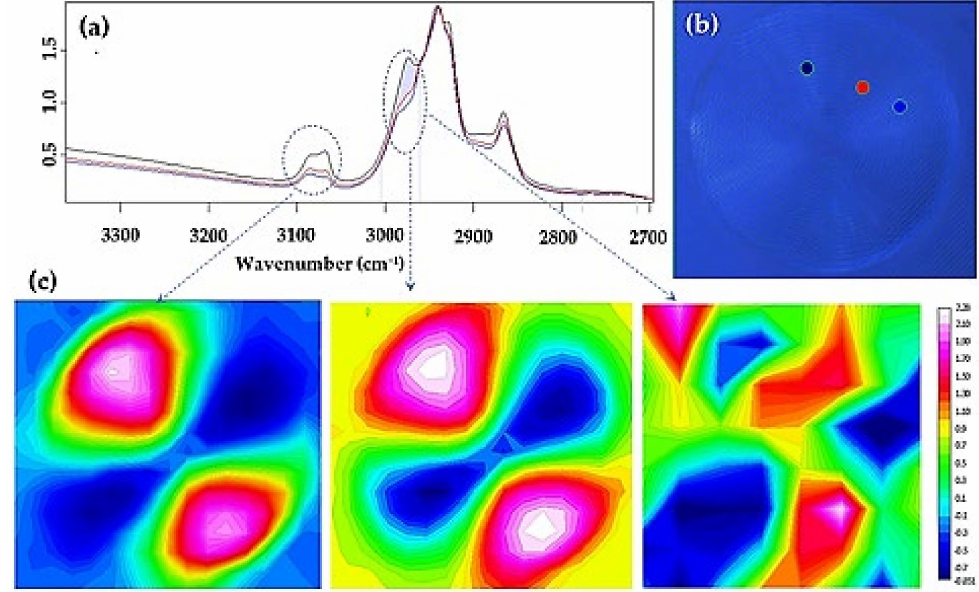
Figure 6. ( a ) FTIR spectra showing the C–H stretching region for PLC and taken from three represen- tative microdomains of the spherulite. ( b ) Micrograph showing a representative banded spherulite and the specific microdomains where FTIR spectra were recorded. Colors are in agreement with those of the FTIR spectra. ( c ) Chemical images obtained from the FTIR bands pointed out by the circle and the ellipsoid. Left and middle images correspond to the bigger spherulites, while the right image is derived from the smaller